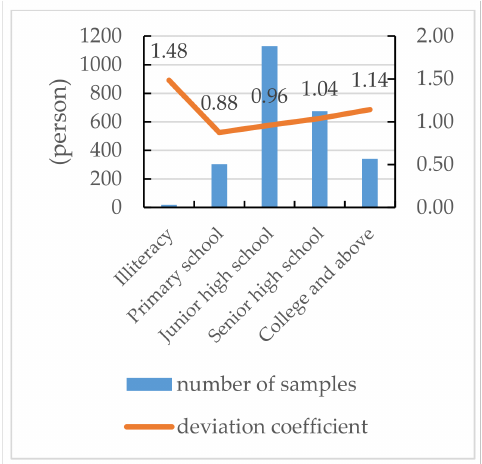
Figure 6. Deviation coefficient of agricultural machinery utilization rate grouped by education.